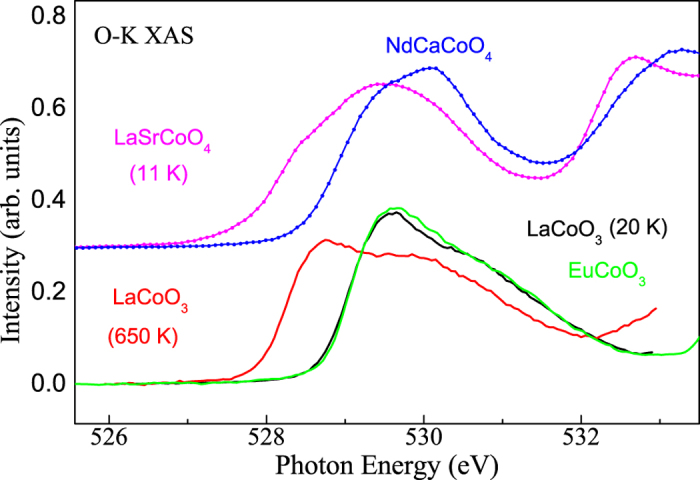
O-K X-ray absorption spectra of LaSrCoO4 at 11 K (magenta), NdCaCoO4 at 300 K (blue), LaCoO3 at 650 K, and 20 K (red and black) and EuCoO3 at 300 K (green).